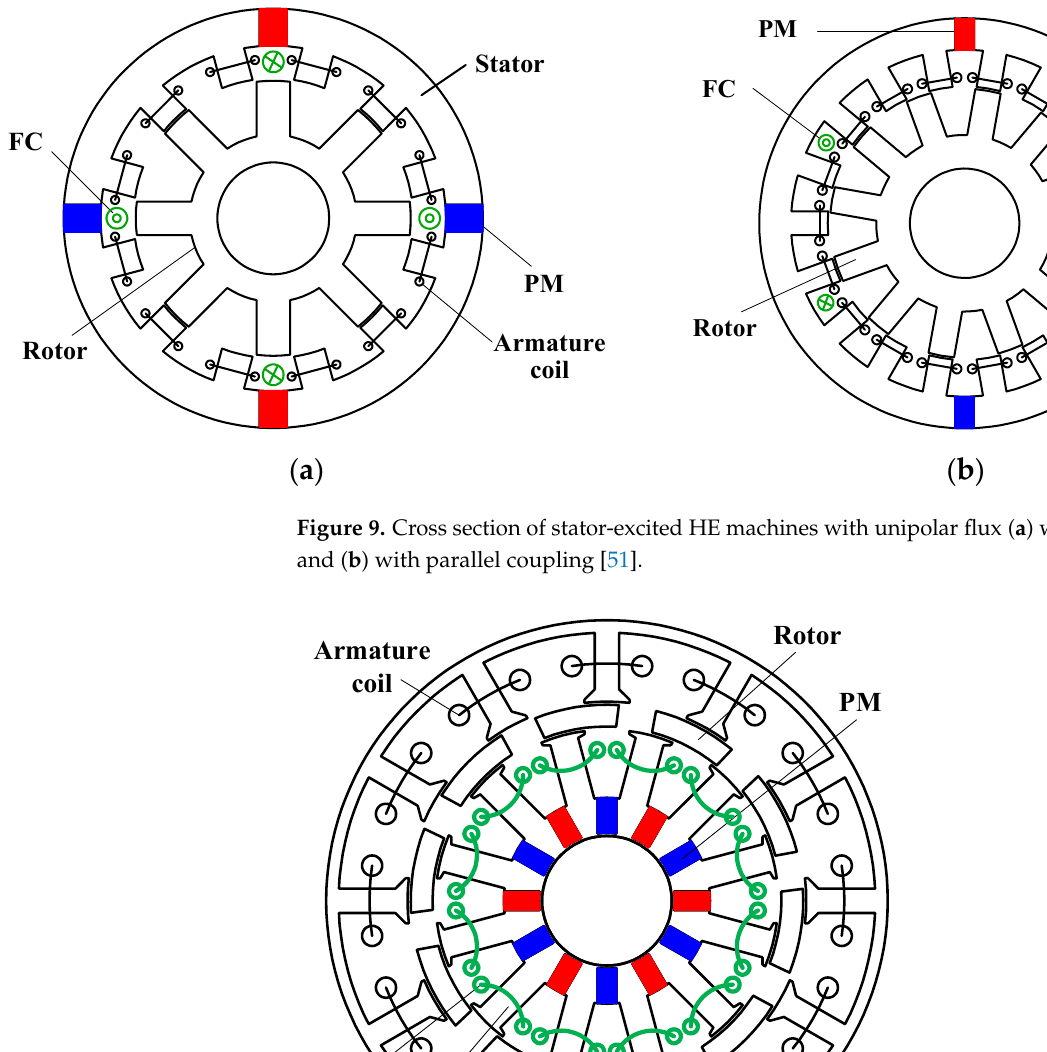
Figure 8. Cross section of stator ‐ excited HE machines with unipolar flux ( a ) with series coupling [41] and ( b ) with parallel coupling [51].